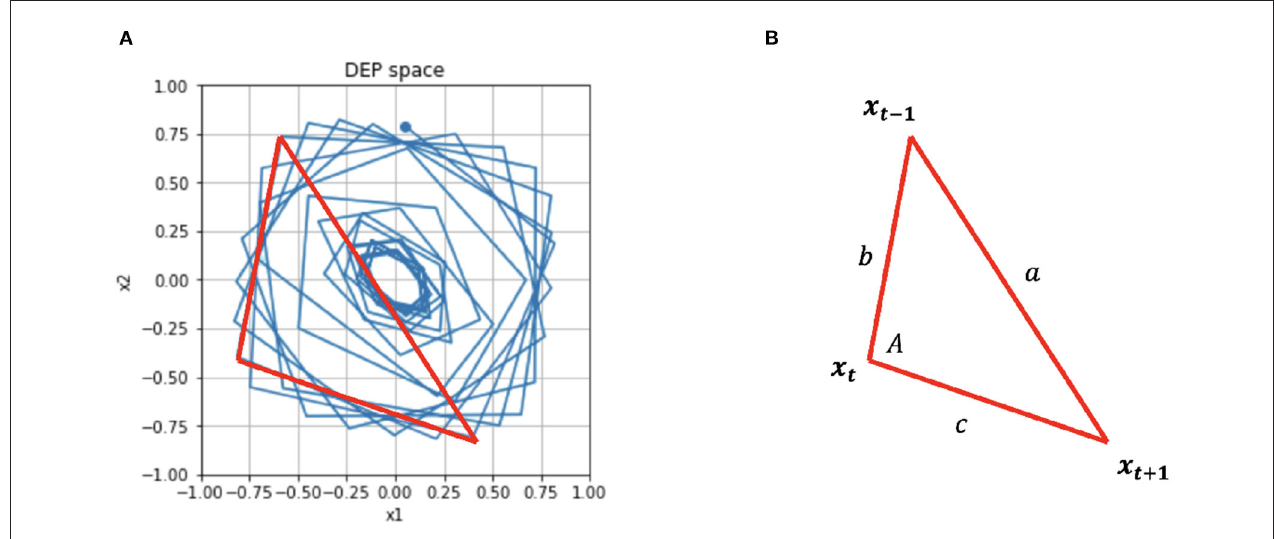
FIGURE 4 | (A) For the circular controller, θ 2 is derived from the angle between subsequent vertices of x . (B) This angle A is calculated by simple geometry.